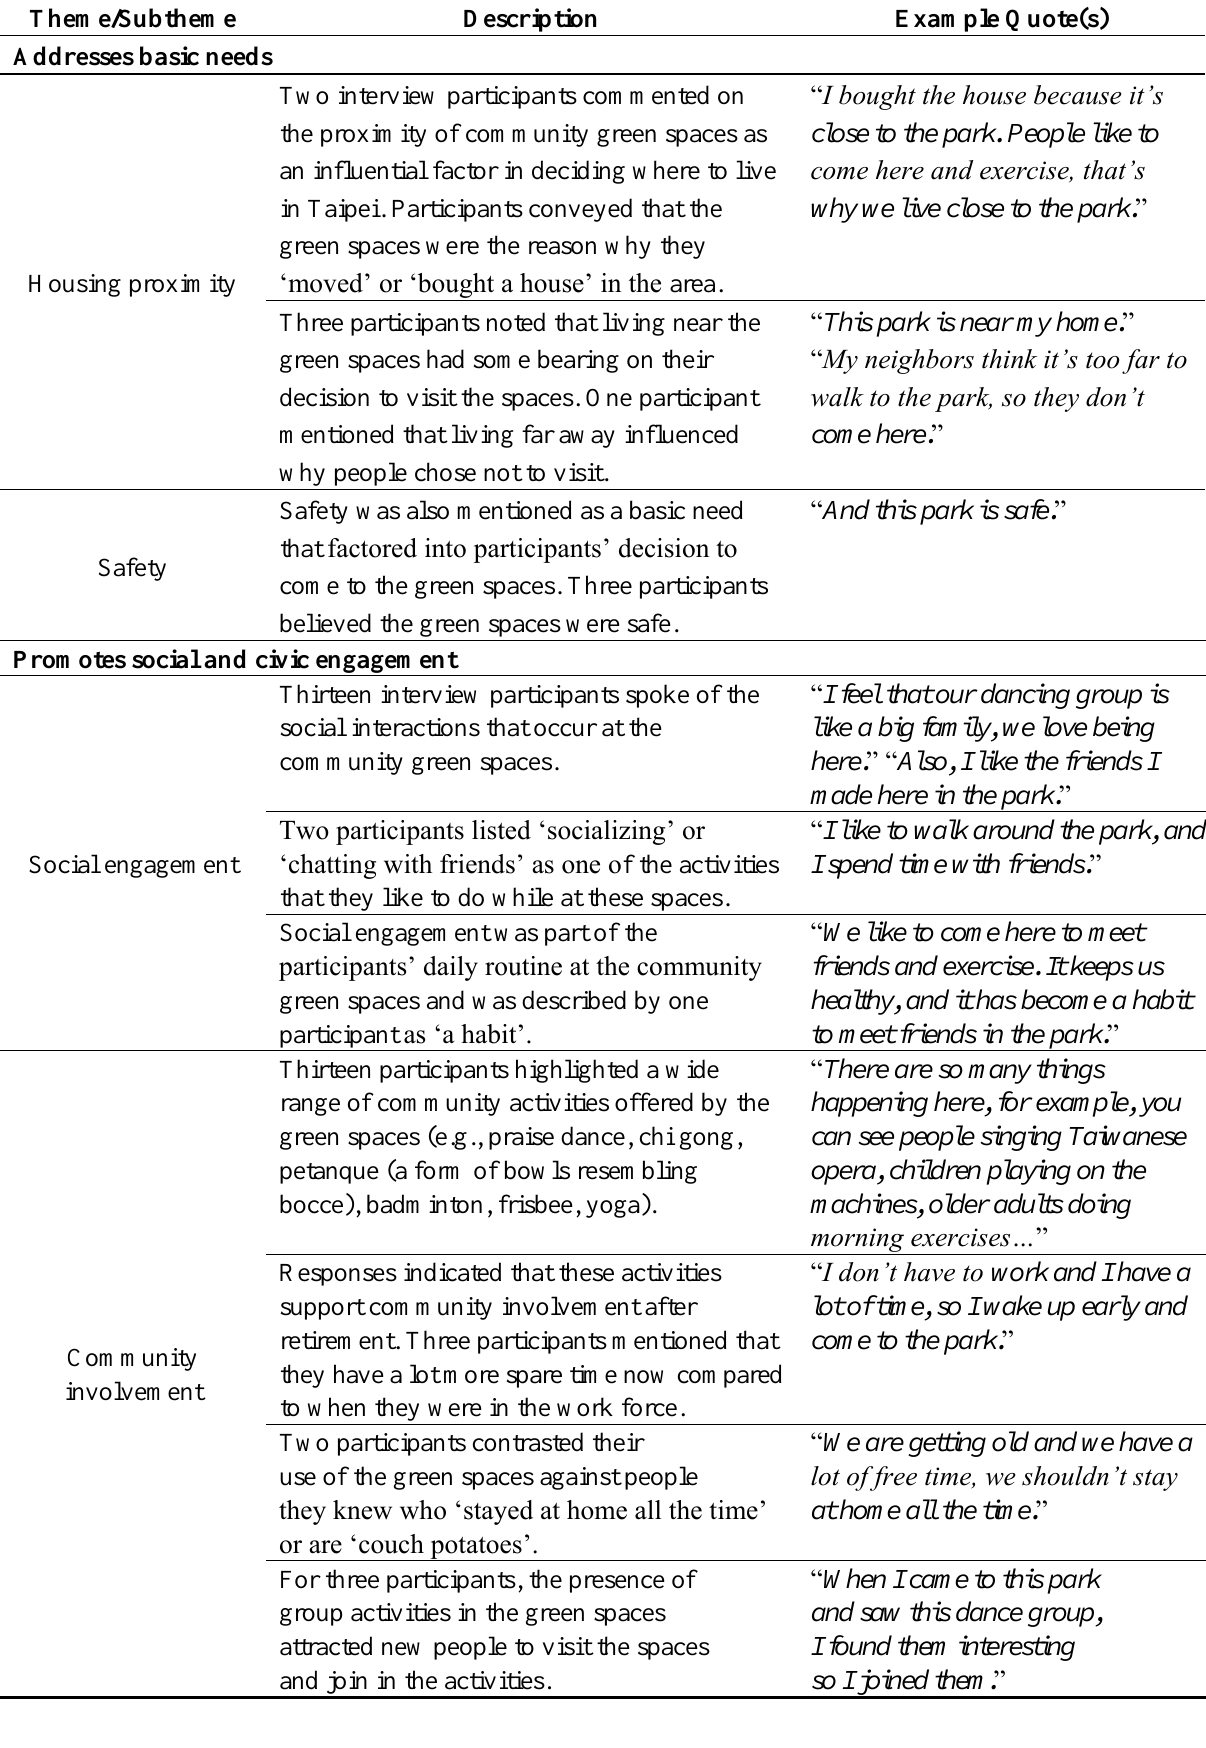
Table 8. Summary of thematic analysis of interview responses.